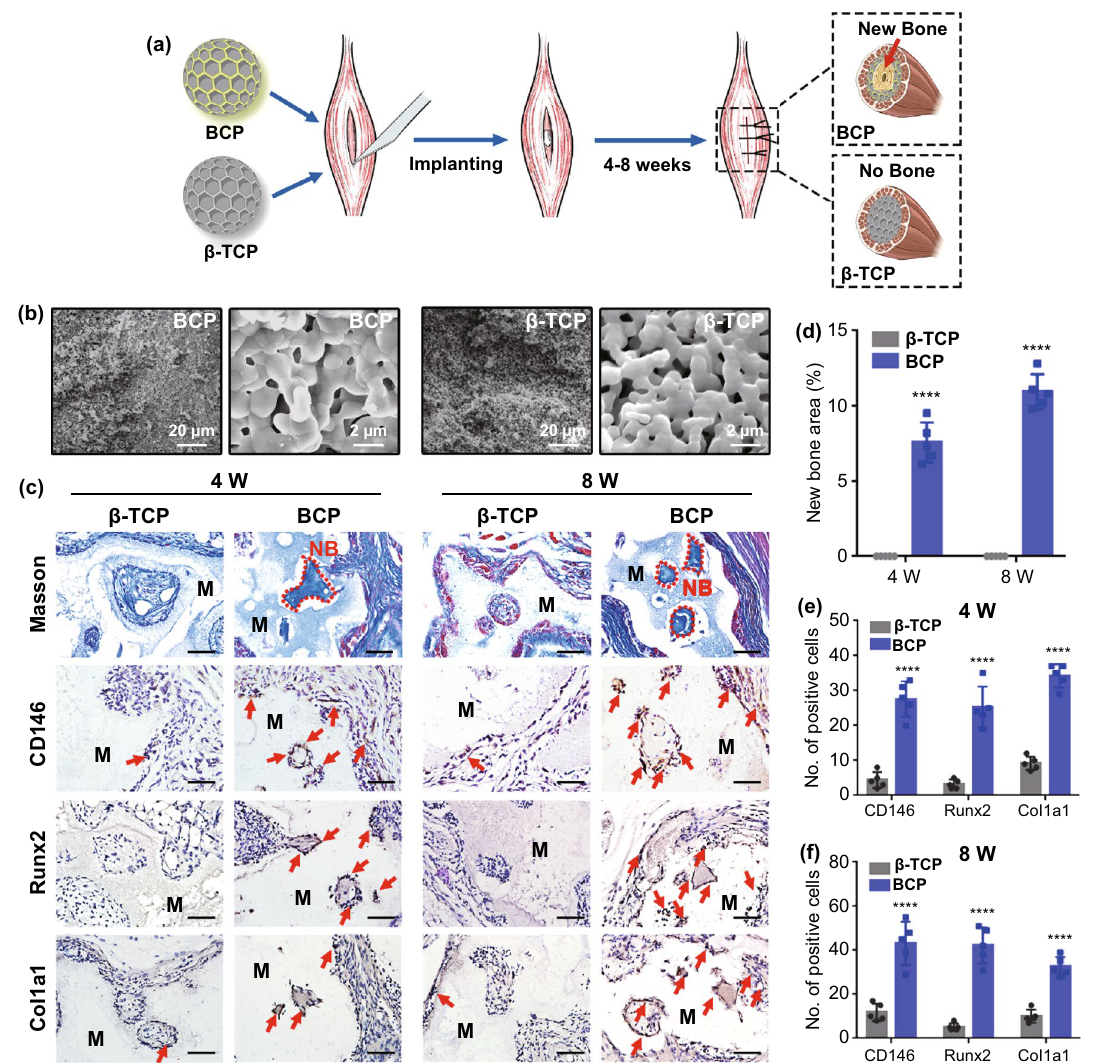
Fig. 1 a Schematic diagram of BCP and β -TCP implantation and new bone formation. b Scheme, morphology and nanostructure of BCP and β -TCP observed by SEM. c Masson staining and IHC staining (CD146, Runx2 and Col1a1: MSC and osteoblast markers, red arrow) of implant area of BCP and β -TCP in vivo after 4 weeks (4 W) and 8 weeks (8 W) (the red dash line shows the new bone formation area; NB, new bone; M, material. Scale bar = 100 μm). d – f Semiquantification of new bone area and positively stained cells in ( d ). n = 5, **** P <